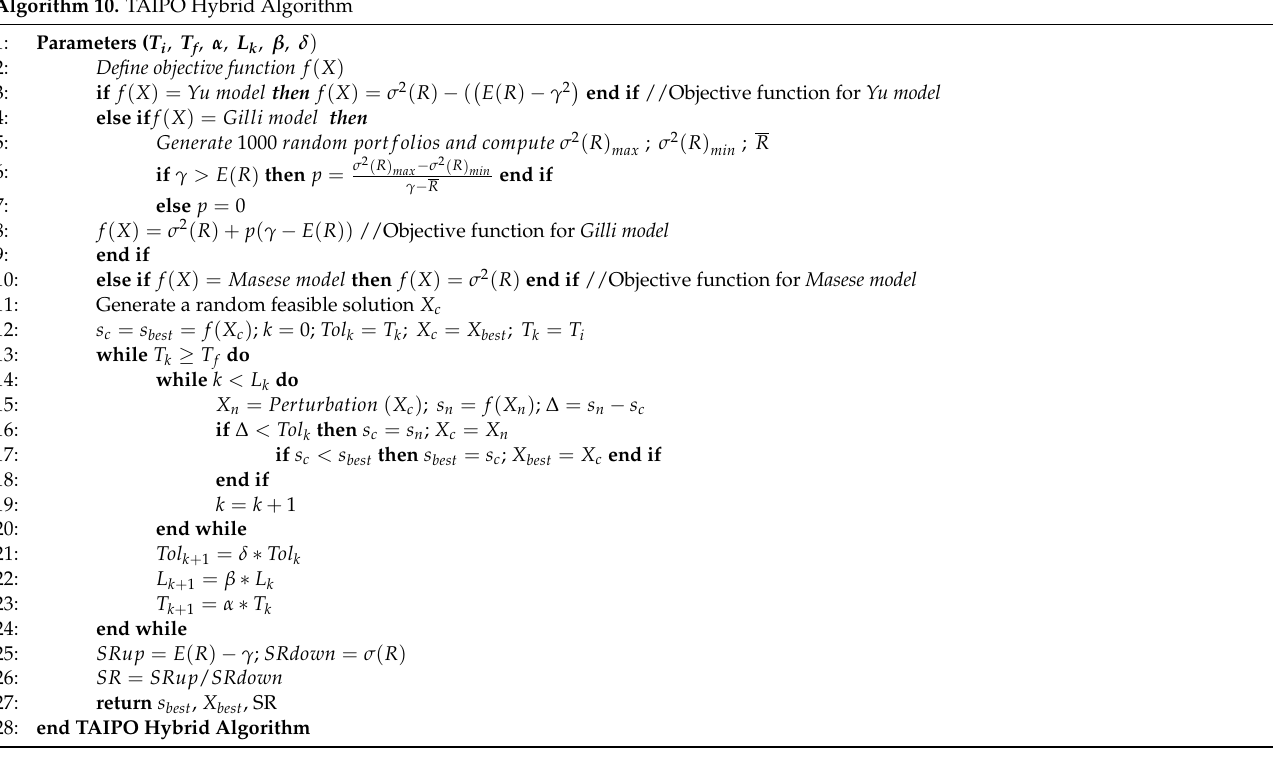
Algorithm 10. TAIPO Hybrid Algorithm